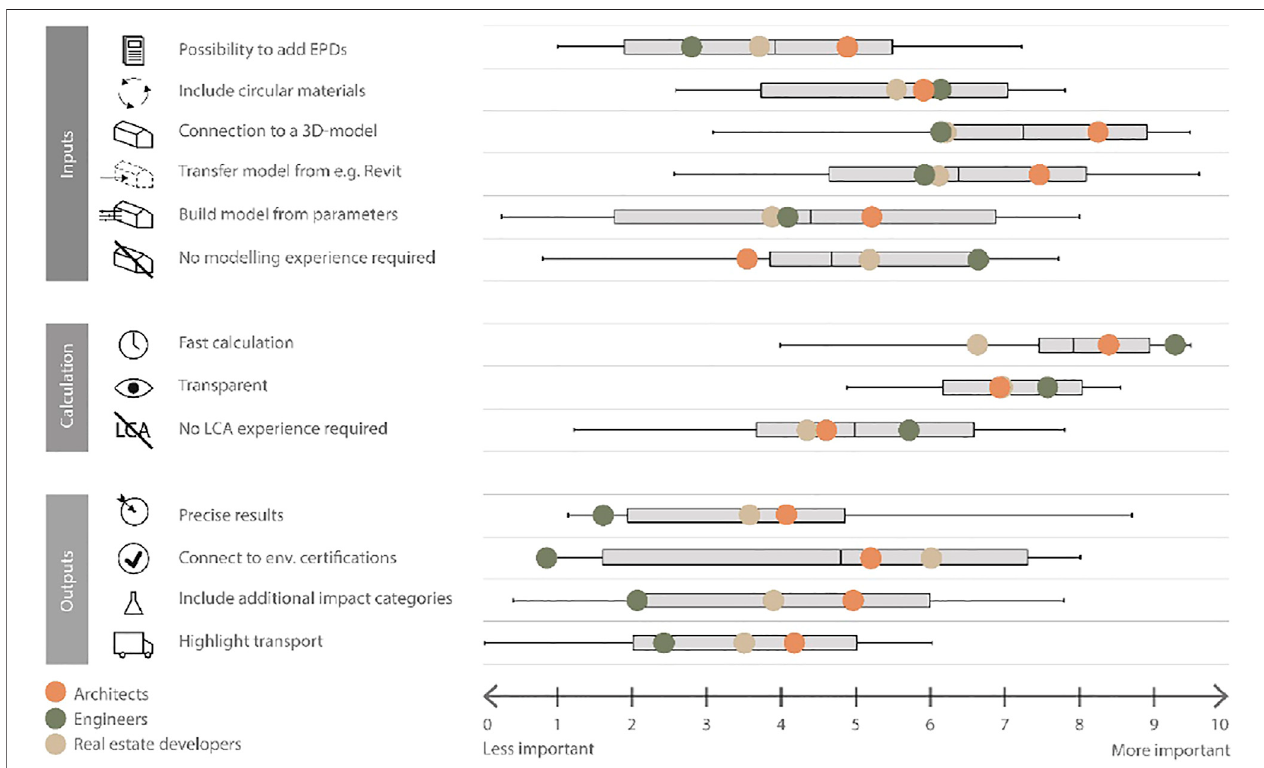
FIGURE5| Boxplotsshowingtheminimumandmaximumvalues,25and75percentilesandmeanvalueforallparticipants.Dotsindicatethemeanvalueforeach profession.